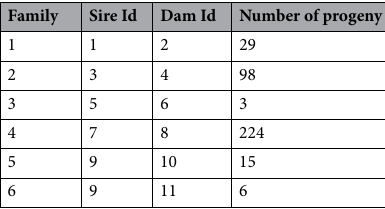
Table 1. Matings and number of individuals sampled from each